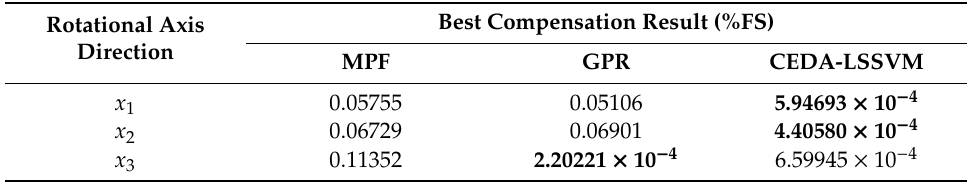
Figure 12. The torque calculation relative error compensated by CEDA-LSSVM. Table 1. The comparisons of the best compensation result by MPF, GPR and CEDA-LSSVM.